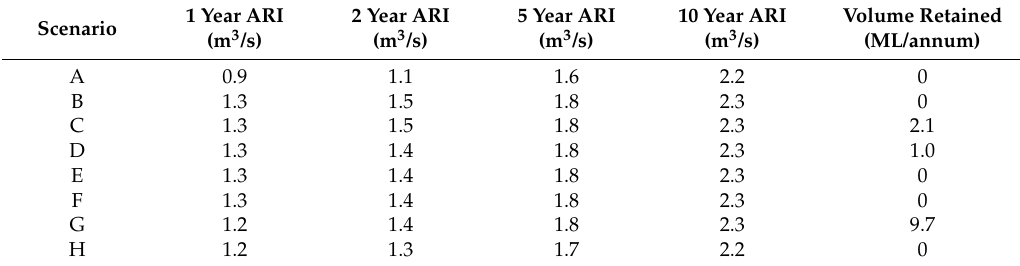
Table 5. Changes in runoff peak flow and volume of runoff for the projected development scenarios.